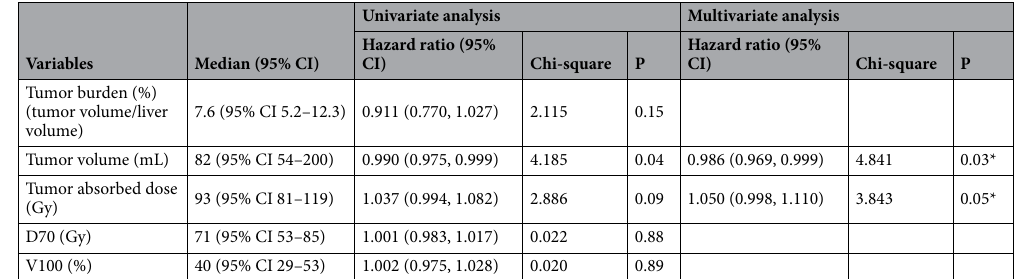
Table 3. Effect of tumor-related continuous variables on time-to-progression.